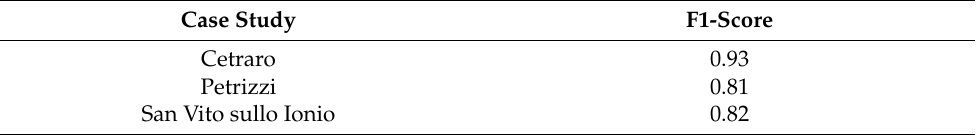
Table 2. Geographic transferability performance of U-Net model considering the entire built-up